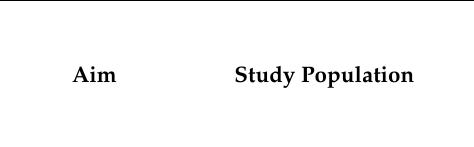
Table 2. Characteristics and patient outcomes of the four randomized controlled trials included regarding adherence to and the maintenance of pain self-management programmes in patients with musculoskeletal pain with a mean age of >65 years. Three studies required an additional two or more references to determine the details of the intervention; a total of four studies reported in nine papers were